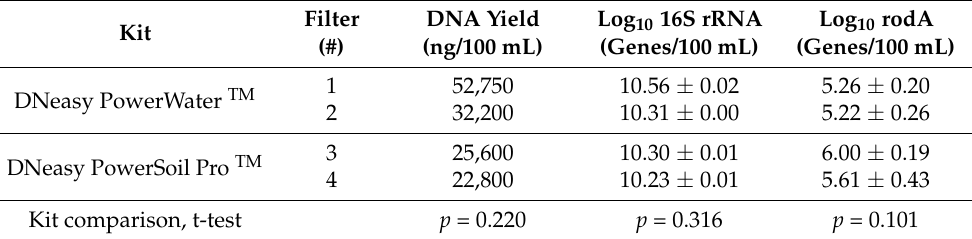
Table 3. DNA yield, 16S rRNA, and rodA gene copies for different extraction kits showing the data for each filter replicate. qPCR results were obtained with the ribolyzer and portable qPCR instrument. Errors are the average and standard deviation of duplicate analysis from each DNA